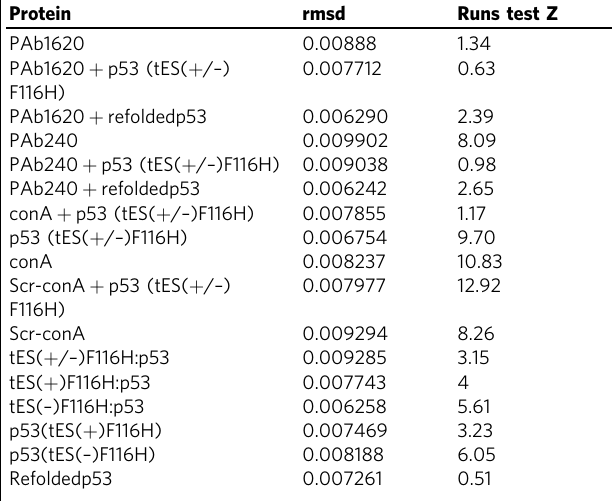
Determining the quality of fi t for AUC curve for p53 encapsulated, refolded and released from tES( + )F116H, tES( + / – )F116H and tES( – )F116H; p53-DNA mixture (p53 refolded from tES( + / – ) F116H); p53 antibody complex (PAb1620 and PAb240) (p53 refolded using tES( + / – )F116H and without